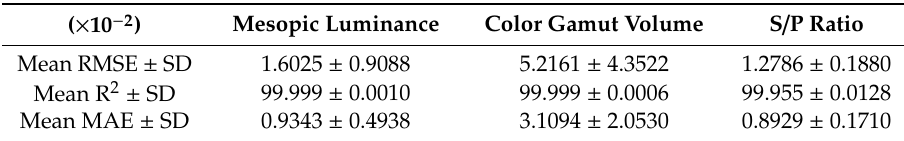
Table 5. Evaluation metrics for machine learning model.